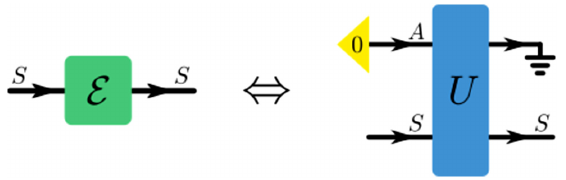
FIG. 11. Stinespring dilation. Any CPTP map on the system S can be represented in terms of a unitary on a larger space SA and final discarding of the additional degrees of freedom. The corre- sponding unitary can be computed by means of Eq. (105). Here, for simplicity, we drop the explicit distinction between input and output spaces we normally